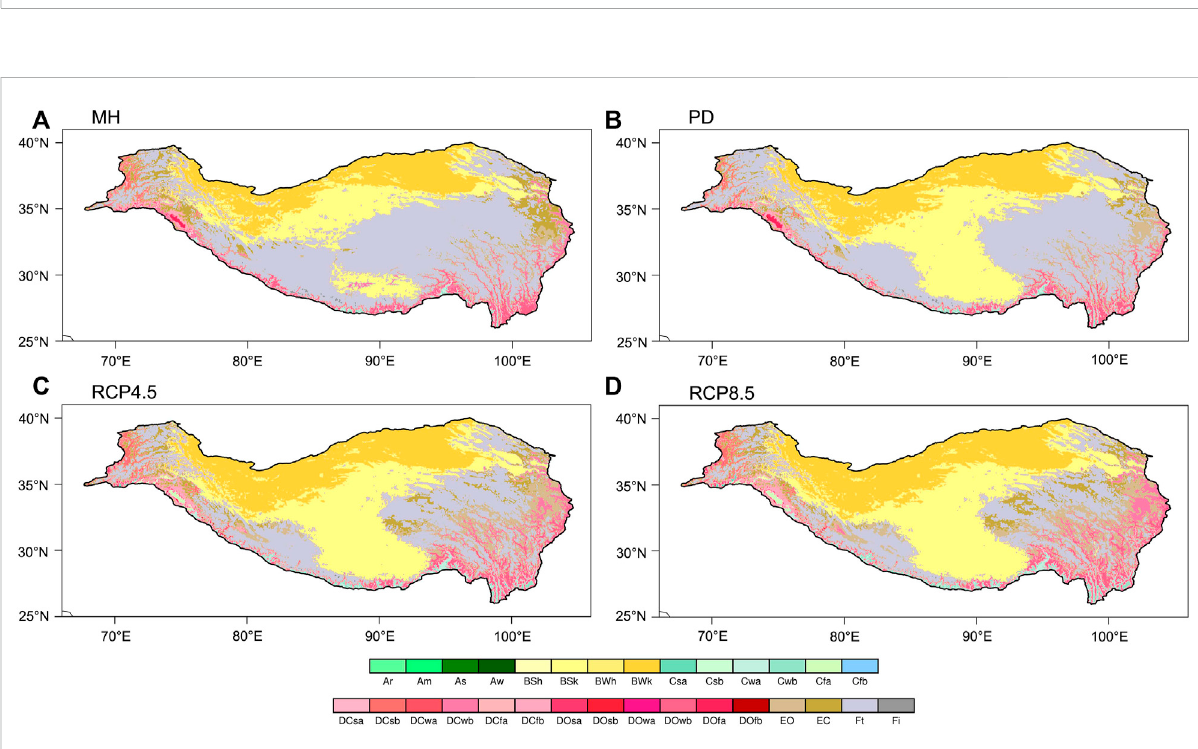
FIGURE 8 Distribution of climate sub-types (detailed information in Table 1) across TP. (A) MH, (B) PD, (C) RCP4.5, (D) RCP8.5.